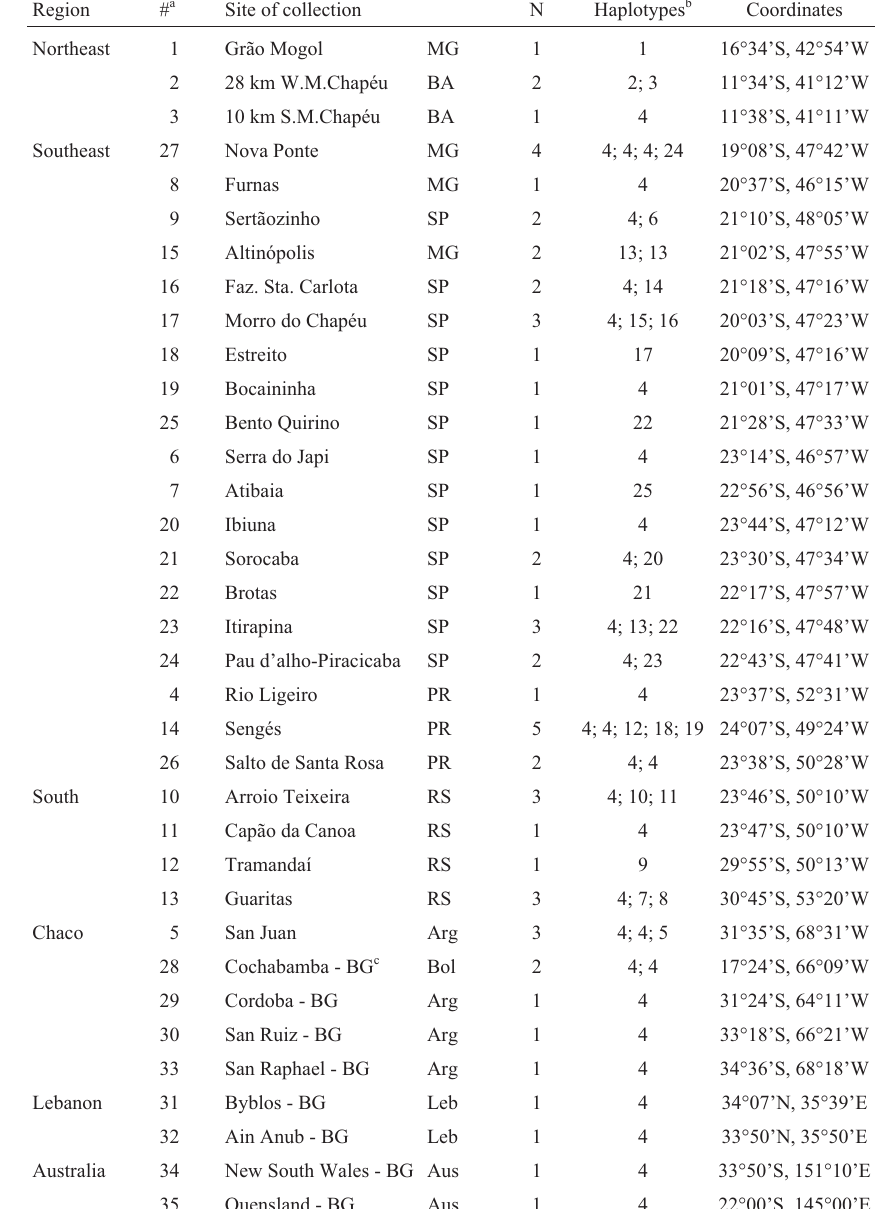
Table I - Haplotypes sampled at various collection sites, listed by region and